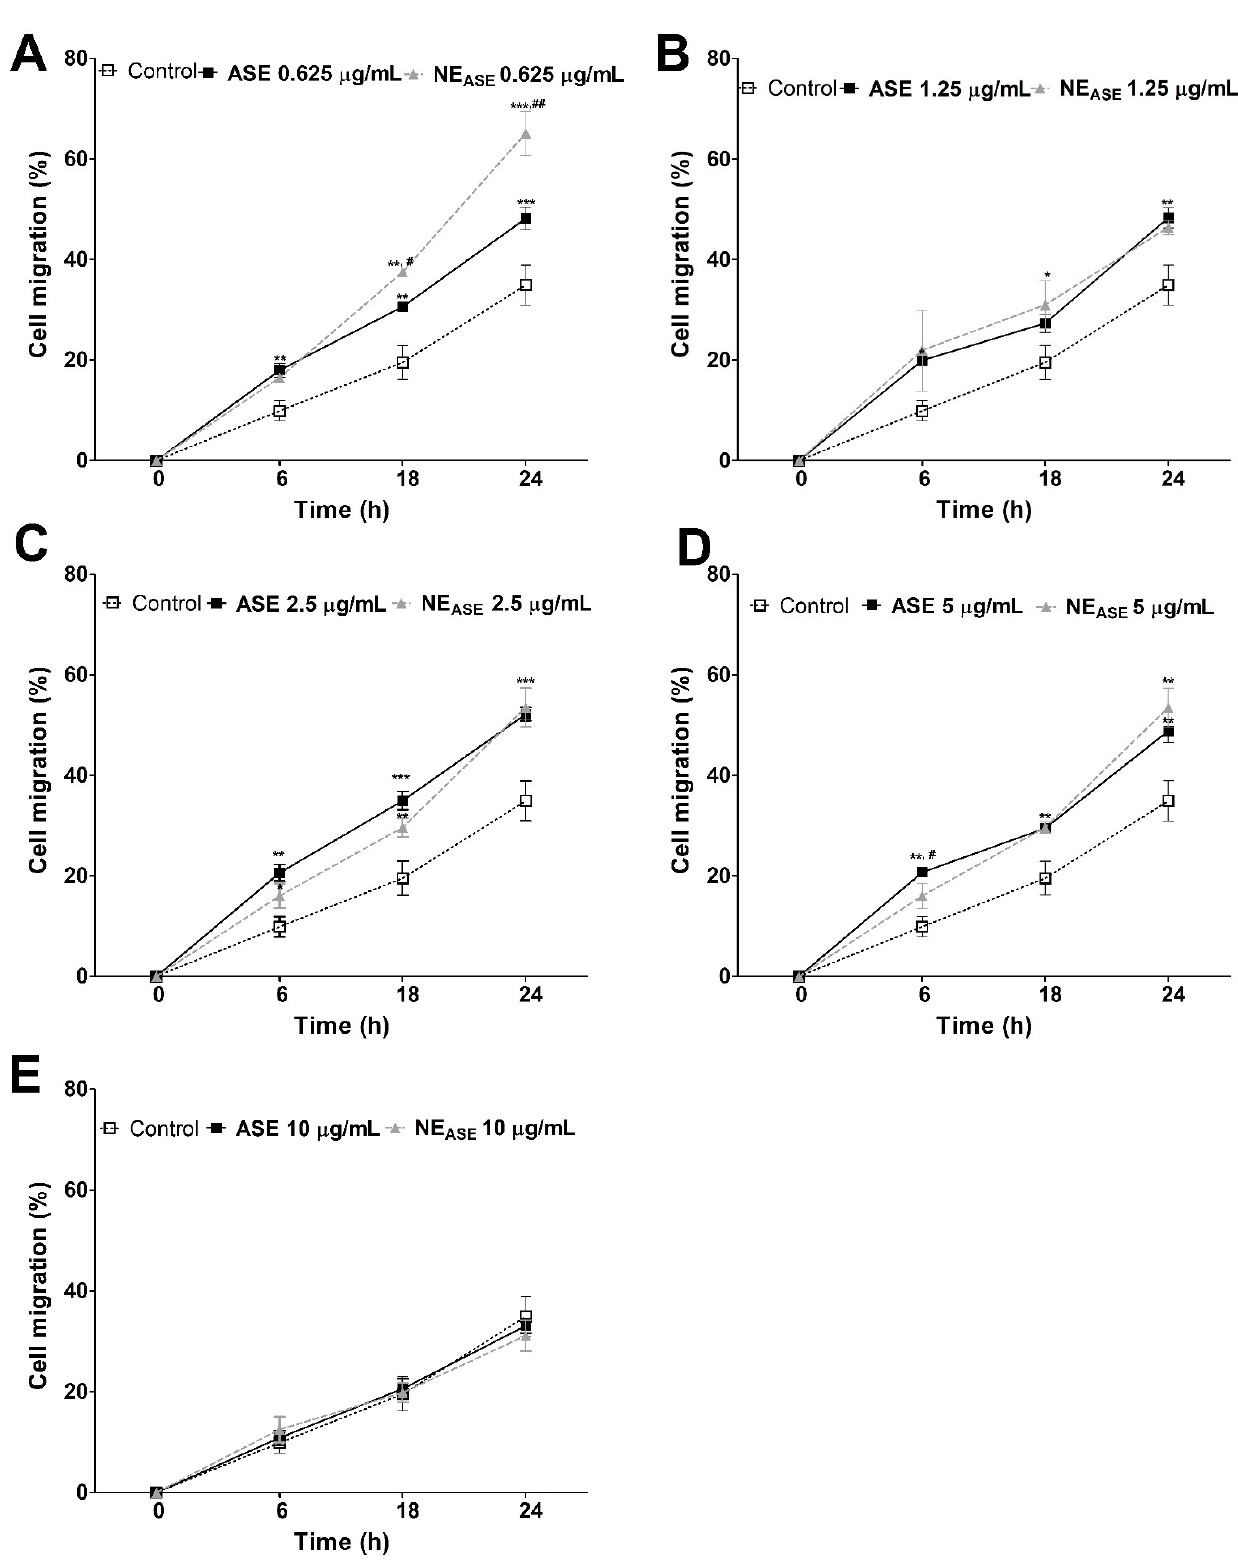
Figure 4. Cell migration (%) of HaCaT (immortalized human keratinocytes) after 6, 18, and 24 h of treatment with ASE and NE ASE at 0.625 ( A ), 1.25 ( B ), 2.5 ( C ), 5 ( D ), and 10 ( E ) µg/mL concentrations. Untreated control group was performed. Value represent mean ± SD for triplicate tests. Data were analyzed by one-way analysis of variance followed by Tukey’s post hoc test. * p < 0.05, ** p < 0.01, and *** p < 0.001, different from control group; # p < 0.05, and ## p < 0.01, different from ASE group. ASE : Achyrocline satureioides extract; NE ASE : Achyrocline satureioides extract-loaded nanoemulsion.